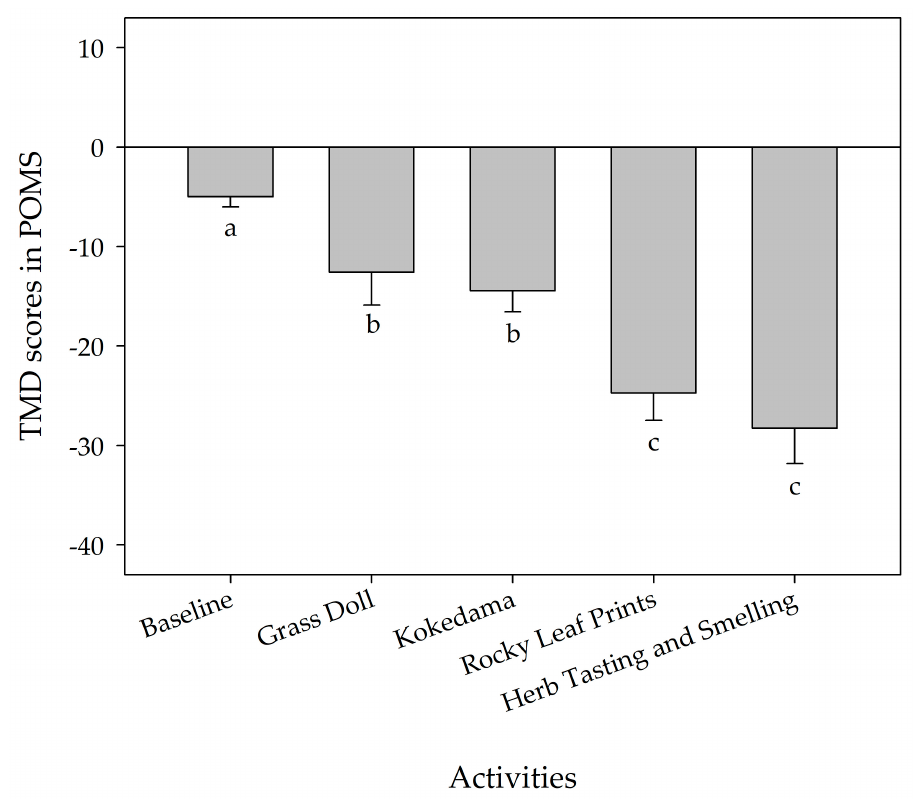
Figure 3. Effect of various types of horticultural activities on the total mood disturbance (TMD) in the Profile of Mood State (POMS). N = 27, mean ± standard error. a, b, c Means within a treatment followed by different letters significantly differ at p ≤ 0.05 by the least significant difference (LSD) test.